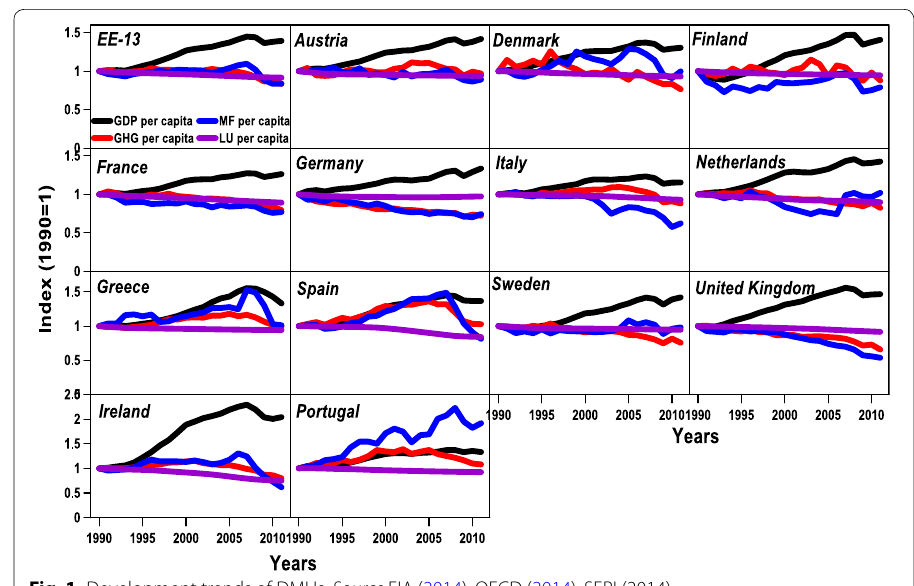
Fig. 1 Development trends of DMUs, Source EIA (2014), OECD (2014), SERI